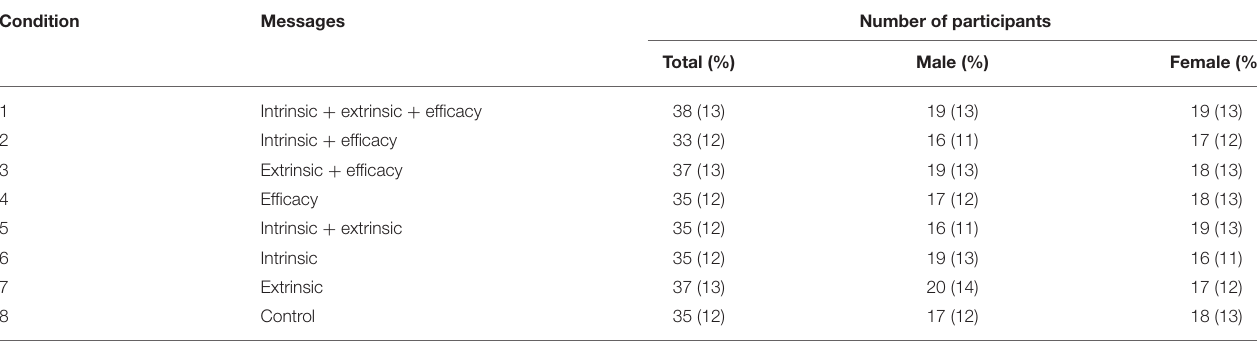
TABLE 2 | Study participants by experimental condition and gender.